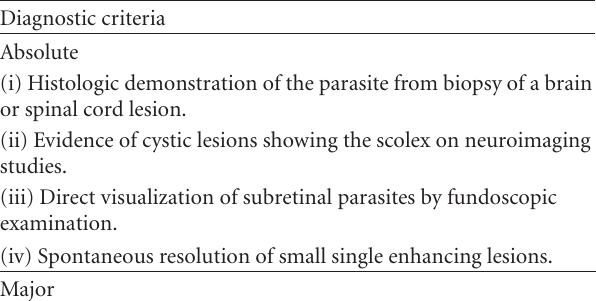
Table 1: Diagnostic criteria and degrees of diagnostic certainty for neurocysticercosis (Modified from: